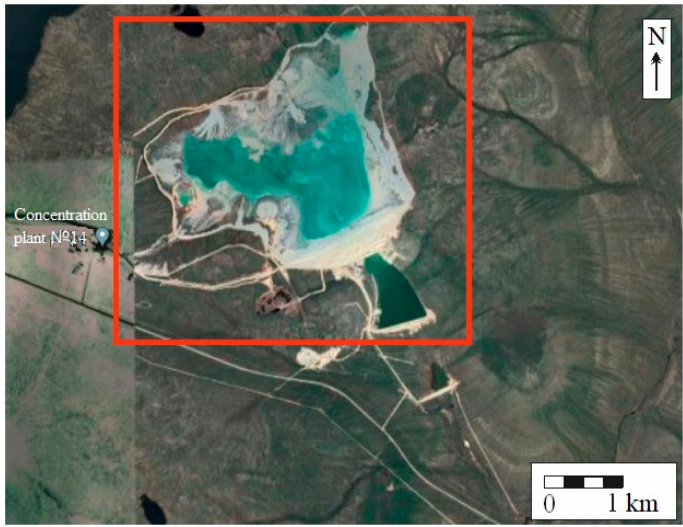
Figure 1. Satellite image of the research area.